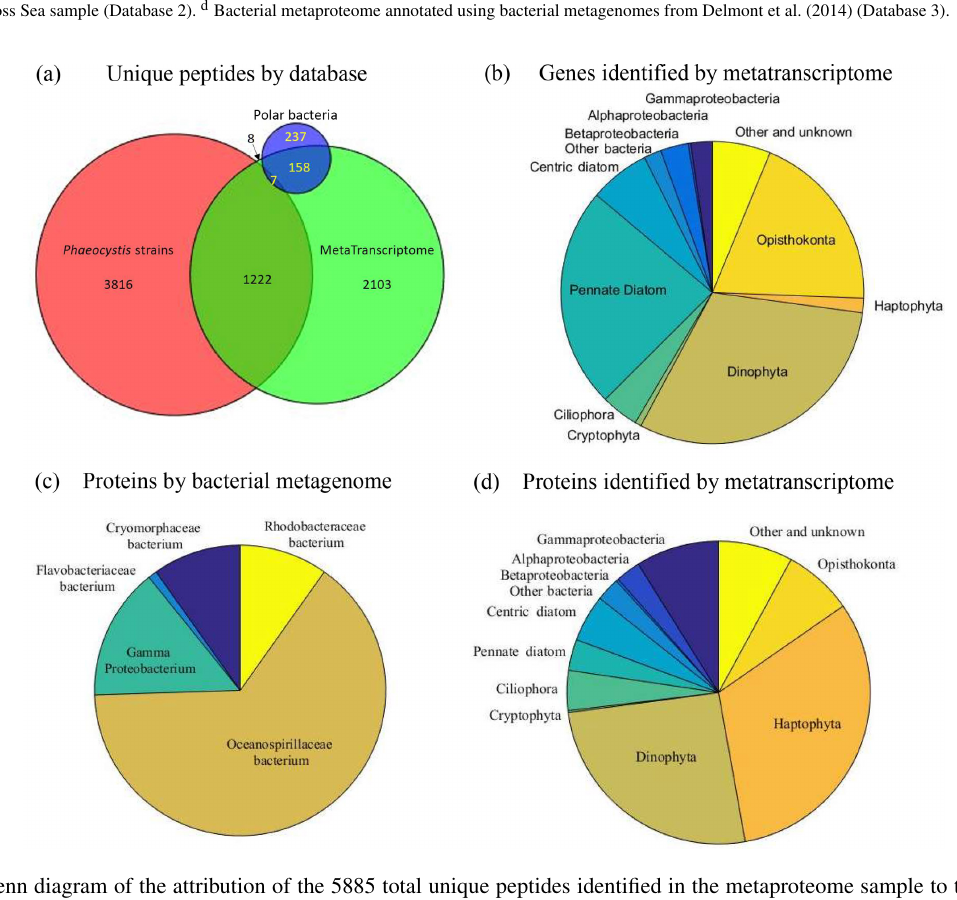
Figure 9. (a) Venn diagram of the attribution of the 5885 total unique peptides identified in the metaproteome sample to three DNA–RNA sequence databases (Table S2). (b) Taxon group composition of genes identified by metatranscriptome analyses (combining total RNA and polyA RNA fractions). (c) Taxon group composition of proteins identified by the bacterial metagenomic database (Database 3). (d) Taxon group composition of proteins identified by the metatranscriptome database (Database